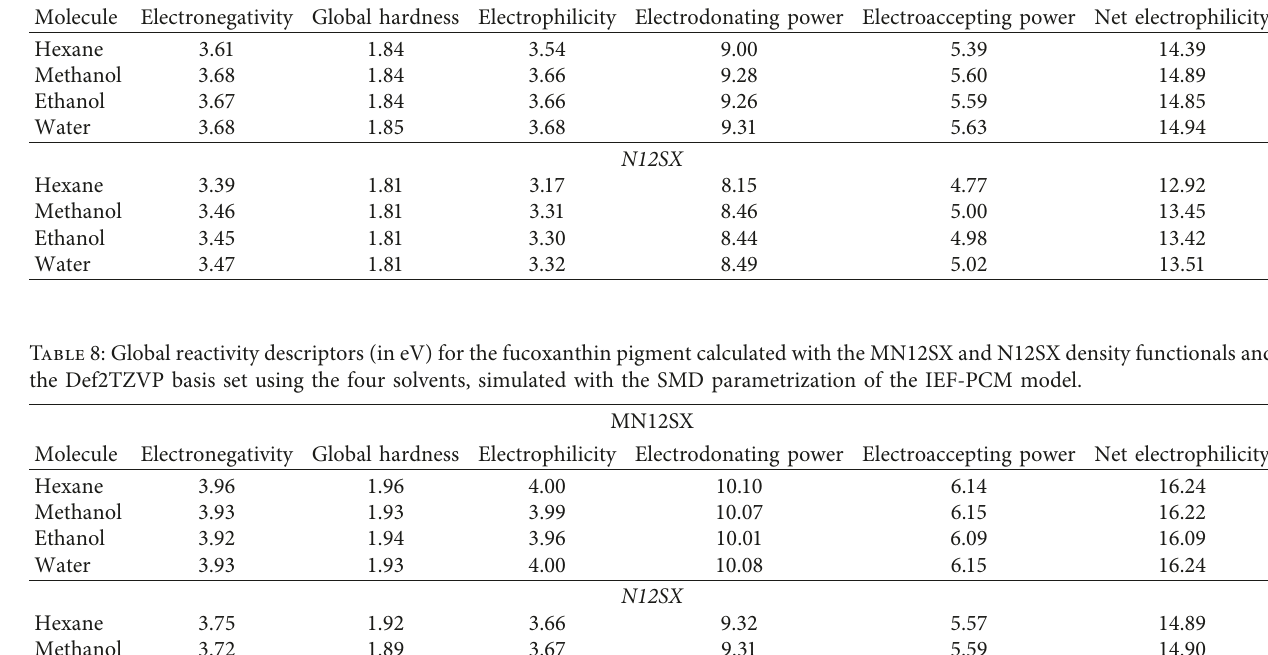
Table 7: Global reactivity descriptors (in eV) for the β -cryptoxanthin pigment calculated with the MN12SX and N12SX density functionals and the Def2TZVP basis set using the four solvents, simulated with the SMD parametrization of the IEF-PCM